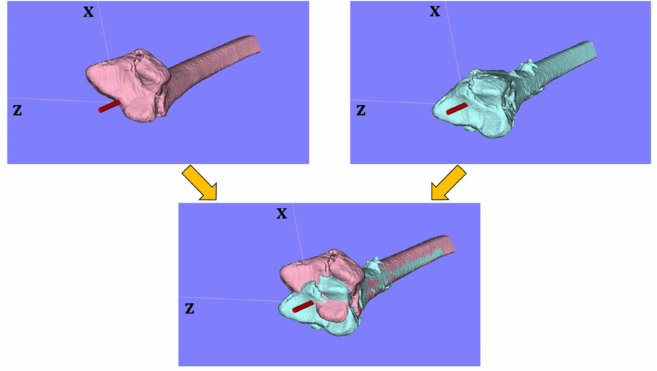
Figure 1. Coordinate system for the 3Dimages. The preoperative and postoperative 3D images were evaluated in the same coordinate system.